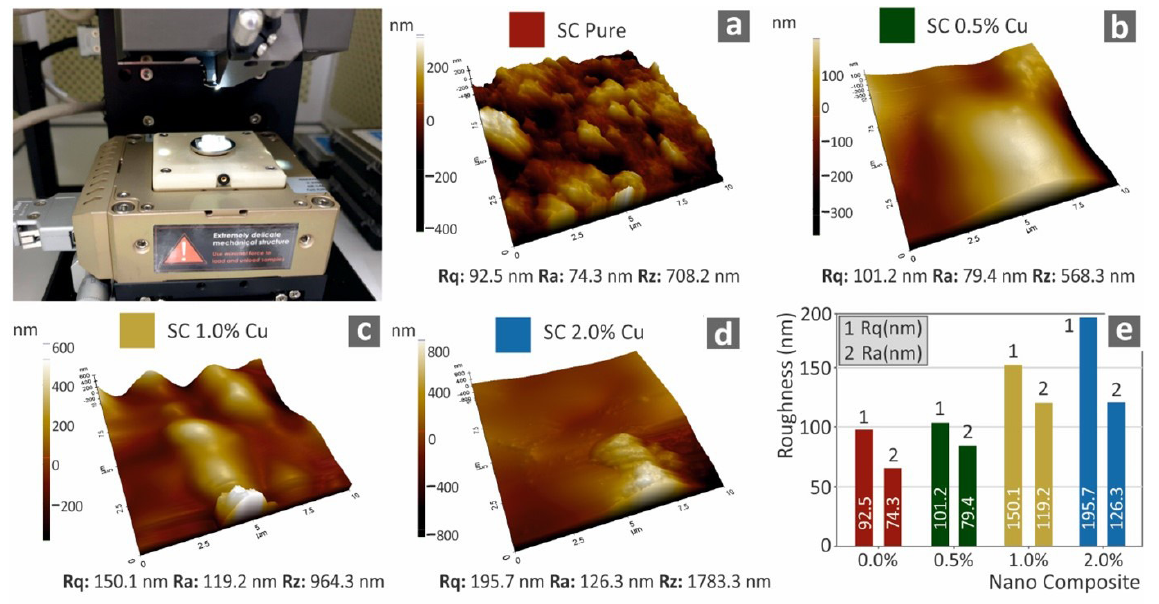
Figure 11. Three-dimensional graphical presentation of the measured with AFM surfaces of 3D printed specimens for all the tested materials ( a )–( d ), ( e ) measured roughness (nm) to filler ratio